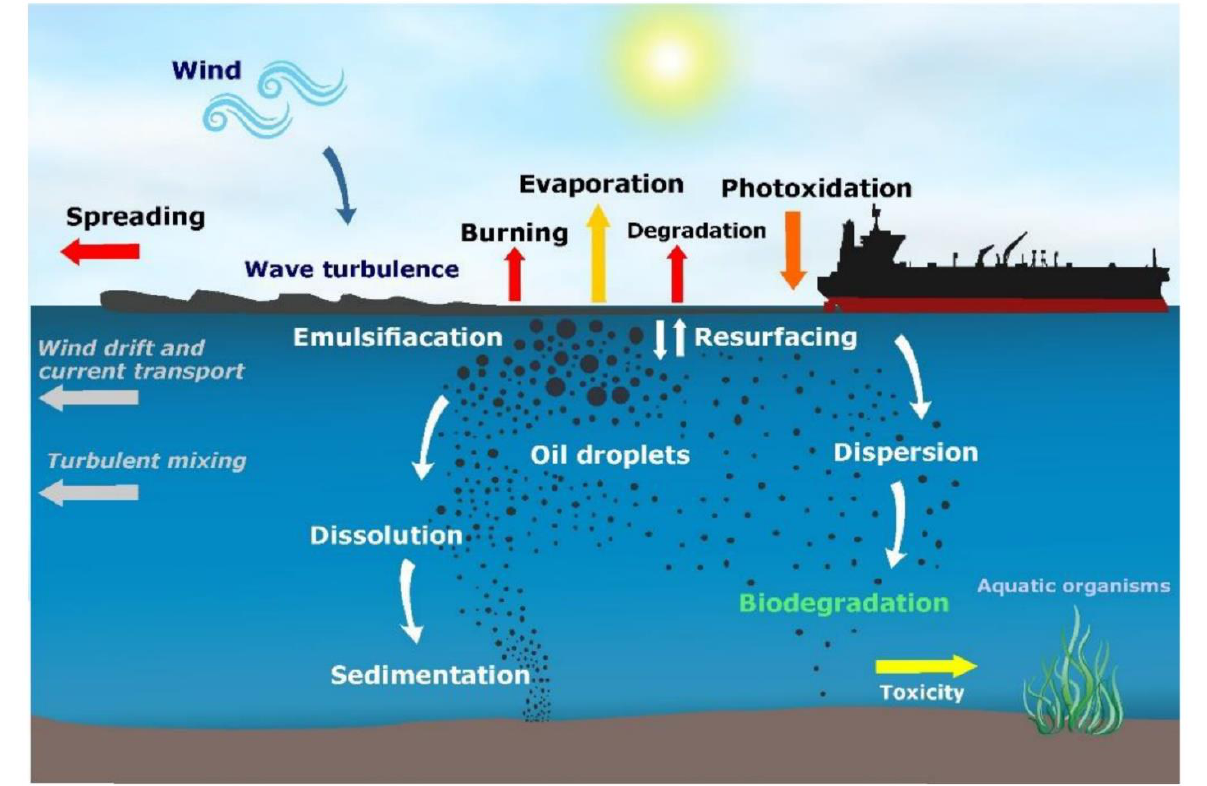
Figure 1. Transportation, weathering and fate of spilled oil in the marine environment. Adapted from Keramea et al. [21].